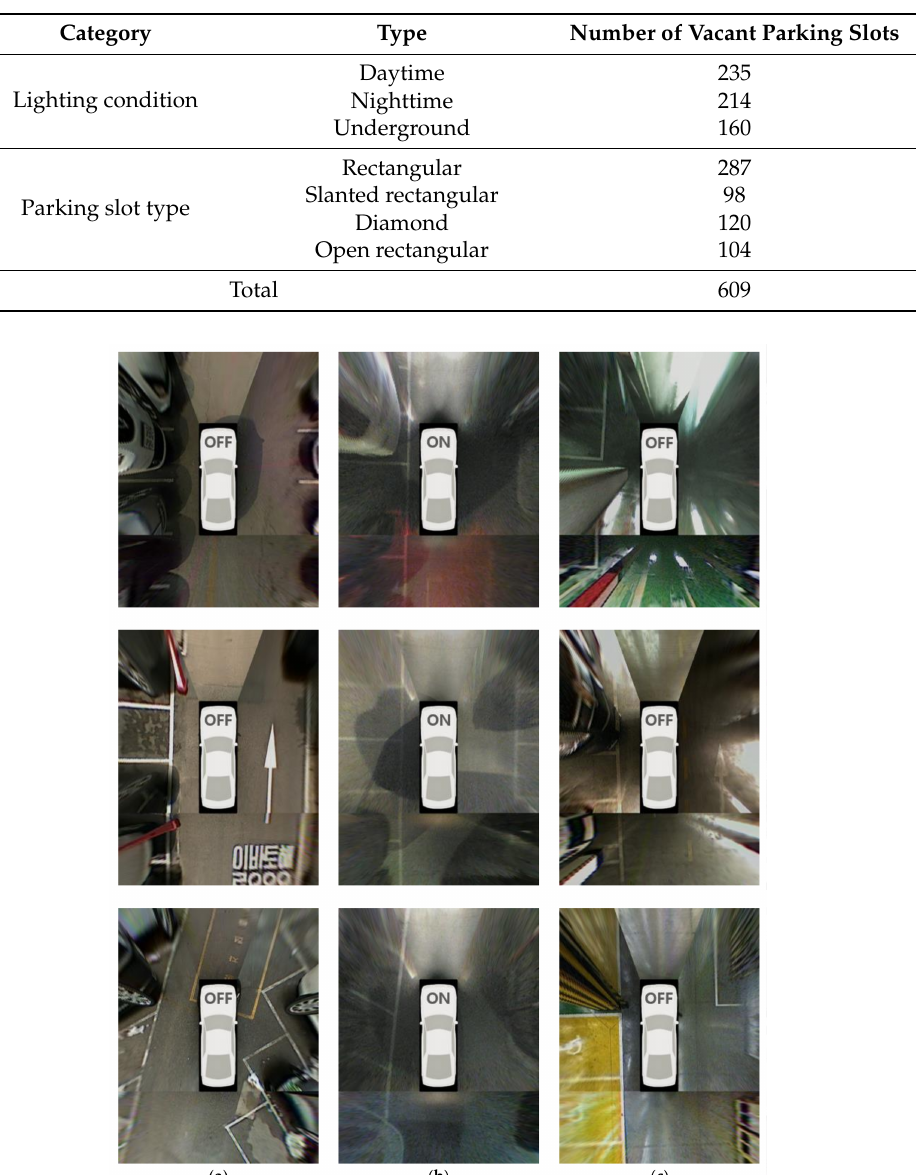
Table 1. Description of the test dataset.